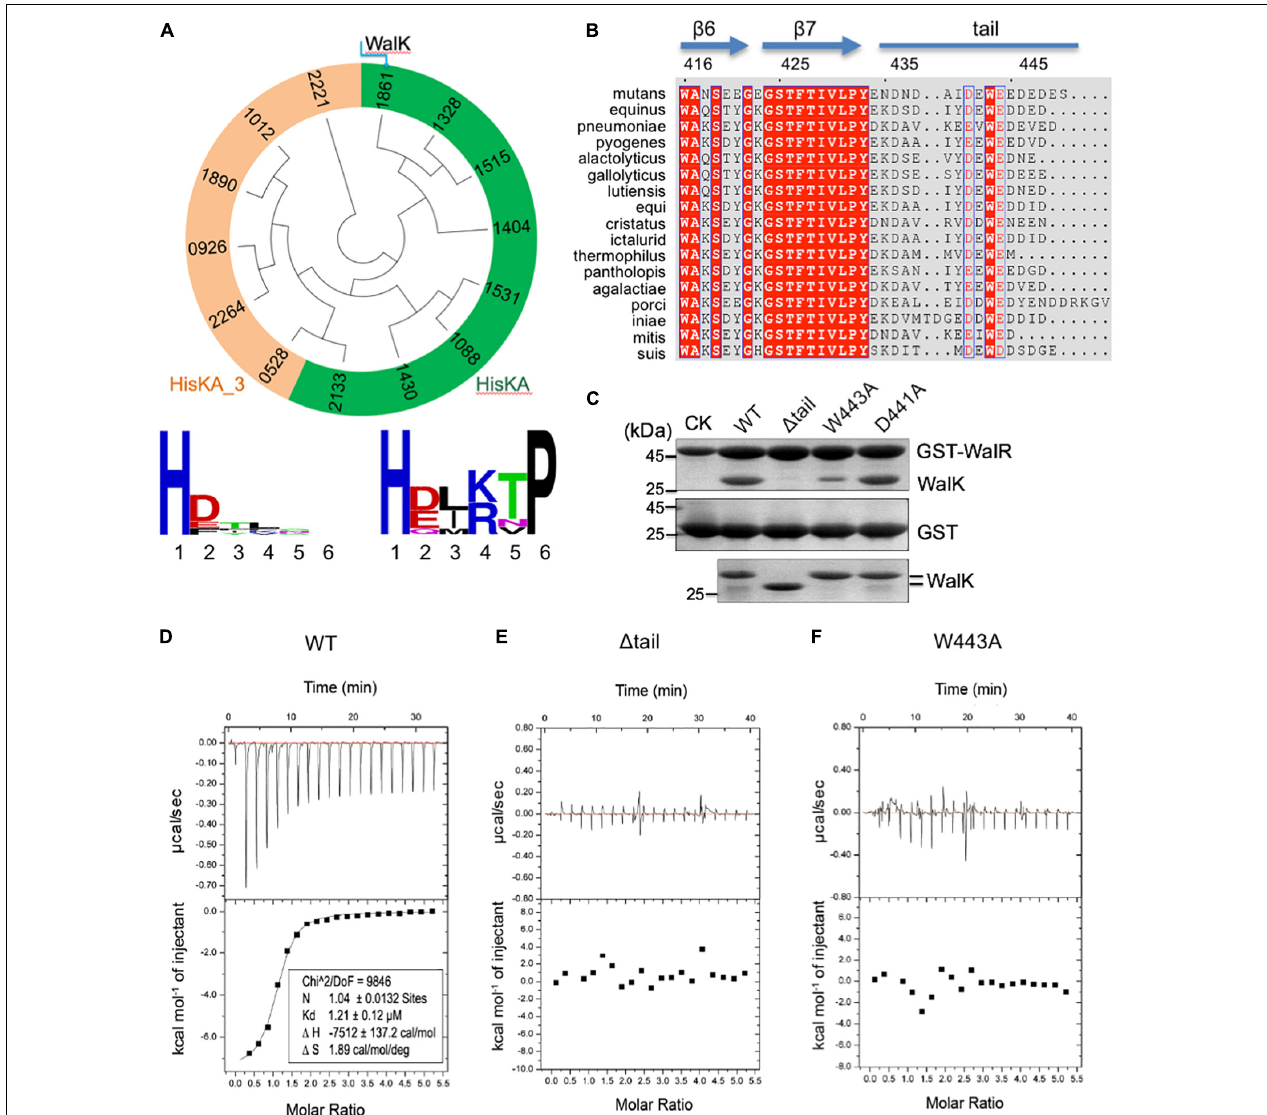
FIGURE 1 | The extended CTT of WalK is unique in S. mutans and required for its interaction with WalR. (A) Phylogenetic analysis of S. mutans HKs. Evolutionary relationship of all 14 HKs is shown in a circular tree, which are grouped into two based on six key residues following their catalytic histidine with conservation for each group below. HKs with a conserved HisKA motif are colored in green. HKs with HisKA_3 motif are grouped in orange. HKs are named with four digits in their protein ID: NP_72****.1. (B) Alignment of streptococcus WalK C-terminal sequences. Completely conserved residues are shown in white with a red background and boxed in blue. Highly conserved residues are in red with a white background and boxed in blue. Marked on top are protein secondary structures and residue numbers in S. mutans . (C) Mutations in the CTT disrupt the WalRK interaction. A GST fusion protein with full-length S. mutans WalR was used to pull-down S. mutans WalK (196–450) WT and mutant proteins (top gel). As a negative control, GST alone was used to pull down WalK WT and mutant proteins (middle gel). Shown in the bottom gel are 10% of the WalK protein levels used above. CK shows GST-WalR or GST used in the pull-down. (D–F) Quantification of the WalRK interaction by ITC experiments. WalK (196–450) WT and mutant proteins were titrated against the full-length WalR, resulting in raw titration curves at the top and their global fittings at the bottom. The derived thermodynamic parameters are shown